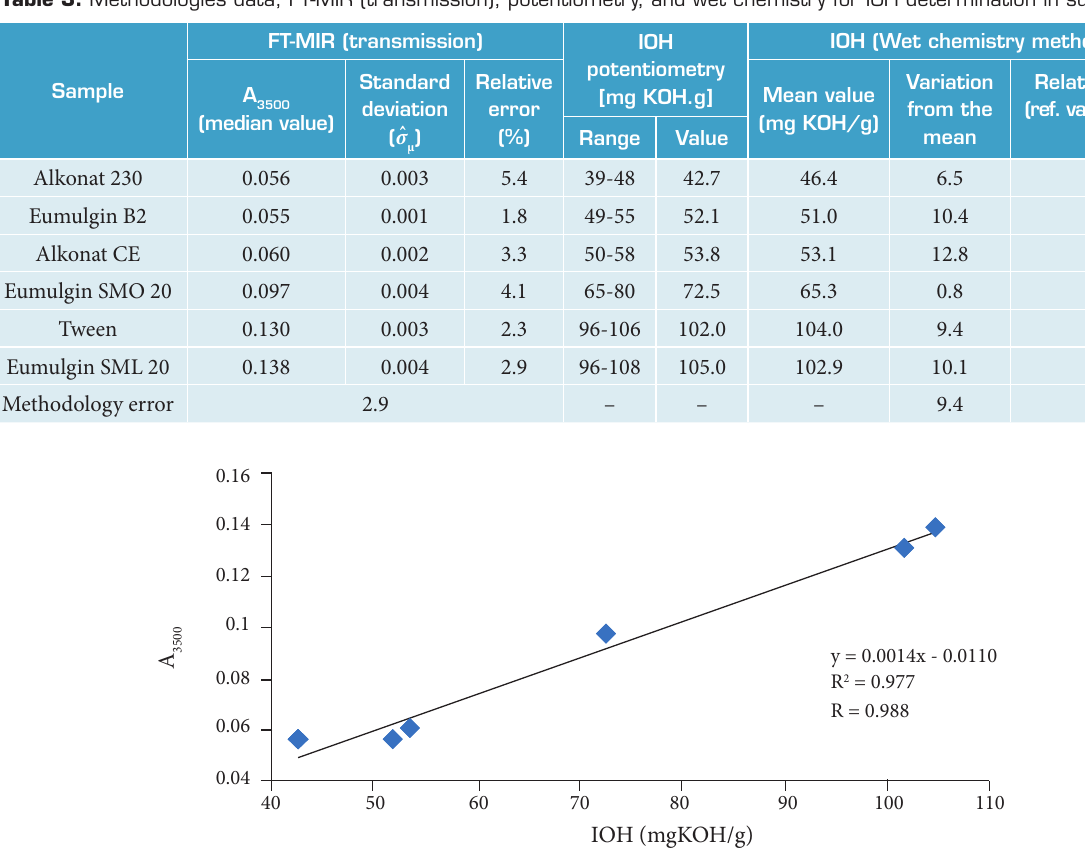
Figure 2. FT-MIR calibration curve (transmission, surfactant solution in CCl A versus IOH (measured by potentiometry, supplier’s 3500